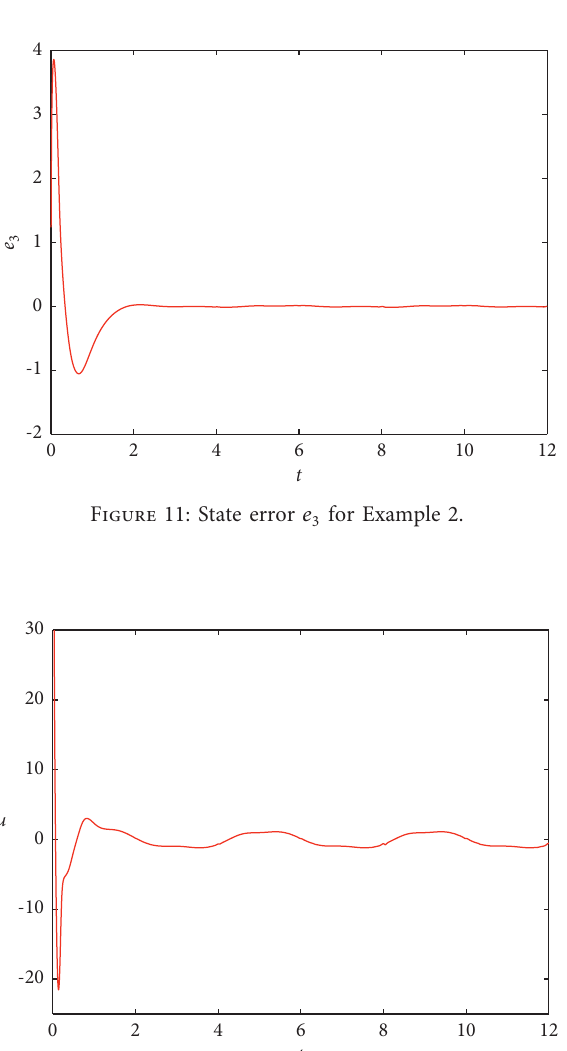
for Example 2. 2